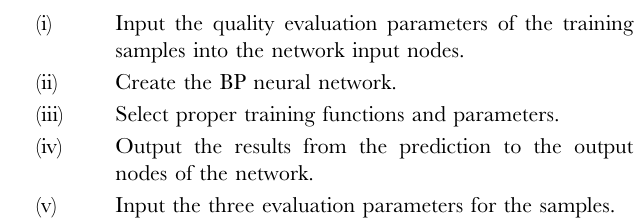
No. Collection place Grade Surface color Fractured surface color Powder color Without coloration Without coloration With coloration Without coloration With